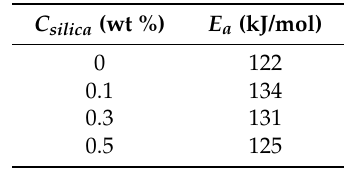
Table 2. The activation energy E a of NEWMS with different silica nanoparticle